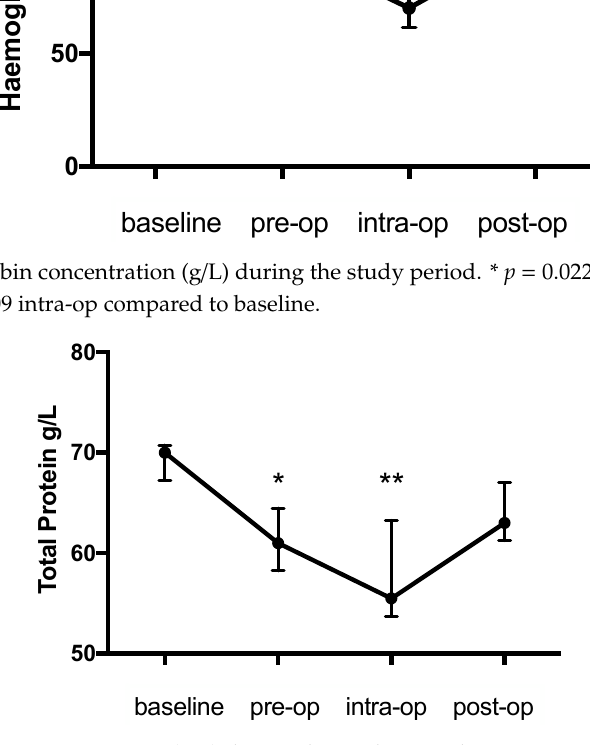
Figure 3. Total protein concentration (g/L) during the study period. * p = 0.0437 pre-op compared to baseline; ** p = 0.0021 intra-op compared to baseline.